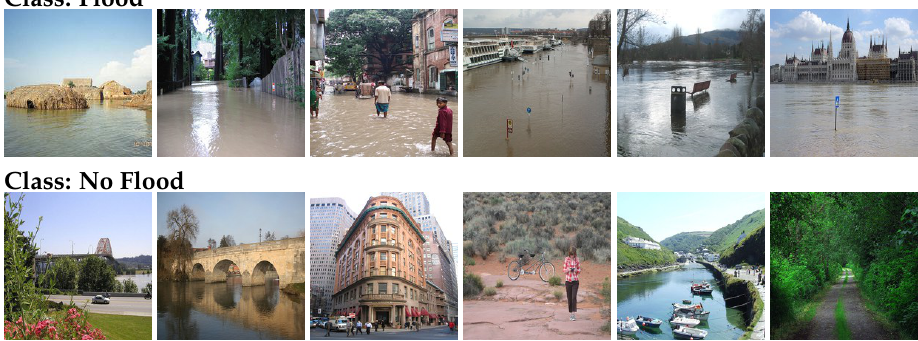
Figure 3. DIRSM Dataset: Random images of “Flood” and “No flood”